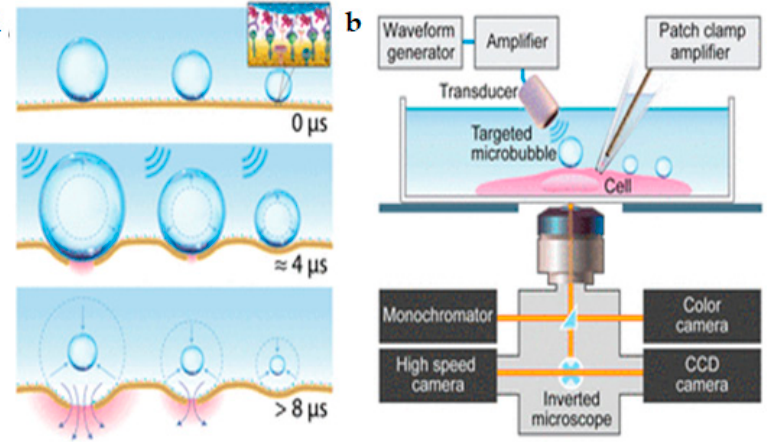
Figure 23. ( a ) Ultrasound excitation of microbubbles attached to the cell membrane via receptor- ligand binding. ( b ) Experimental setup for real-time assessment of single-cell Sonoporation using synchronized simultaneous patch-clamp recording, bright field video microscopy, and fluorescence imaging. Reprinted with permission from ref. [152]. Copyright © 2012 Proceedings of the National Academy of Sciences.